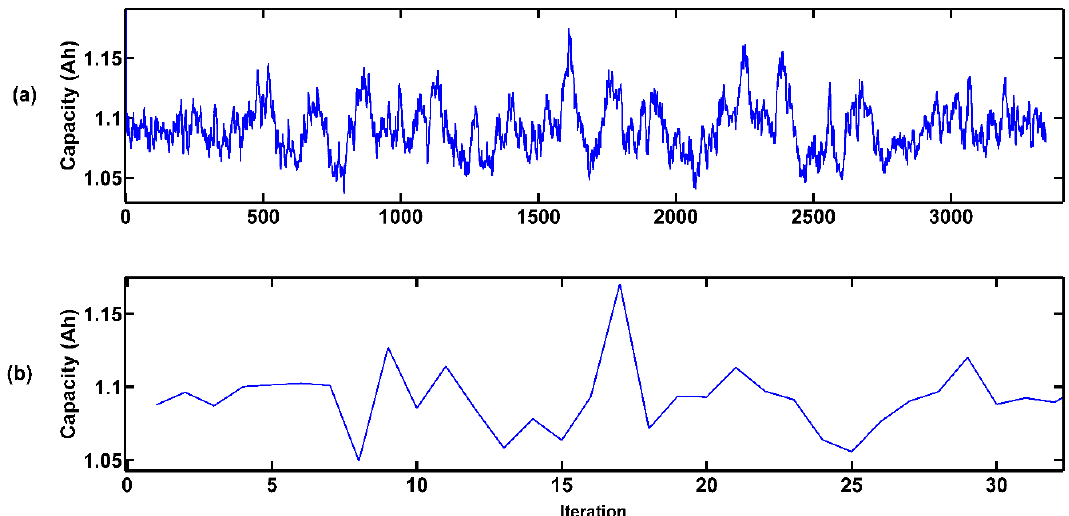
Figure 7. Estimated capacities with EKF ( a ) before filtering; ( b ) after filtering results. X -axis is